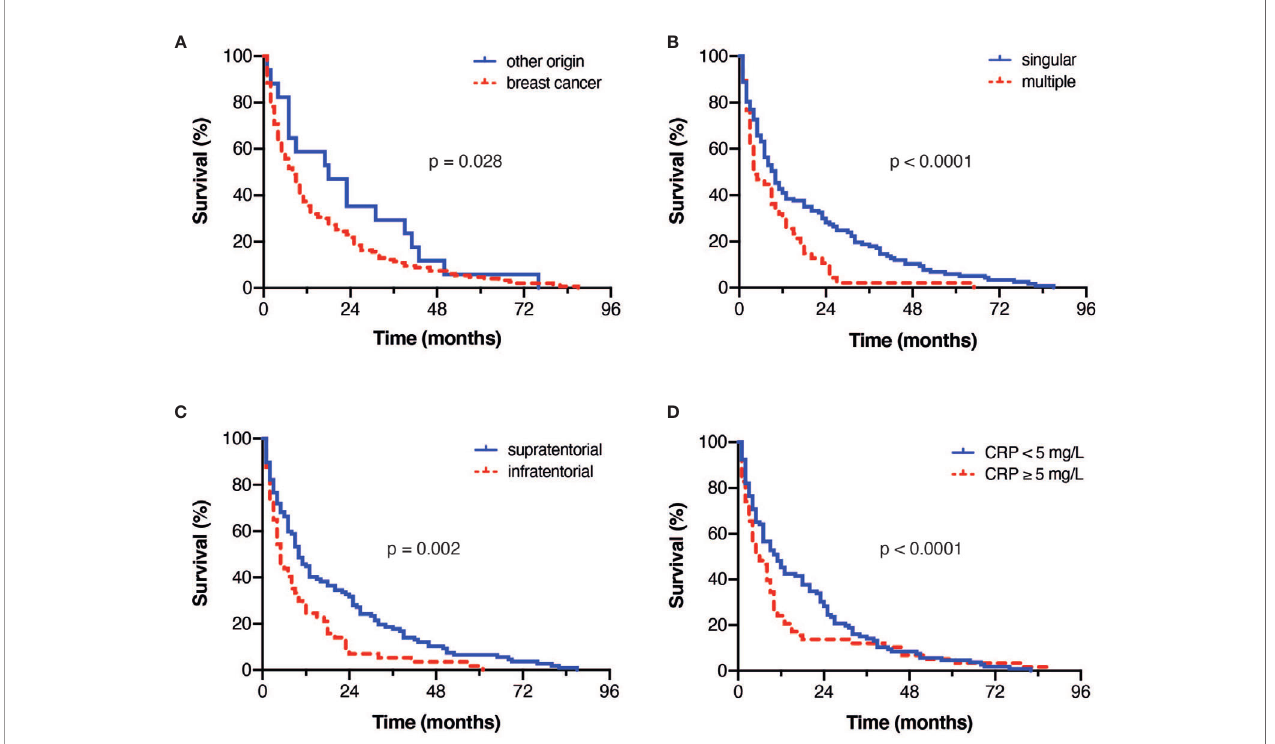
FIGURE 1 | Kaplan Meier-survival curves strati fi ed by (A) cancer of breast versus other origin (B) singular versus multiple metastatic lesions (C) supra- versus infratentorial BM localization (D) and CRP value cut-off as